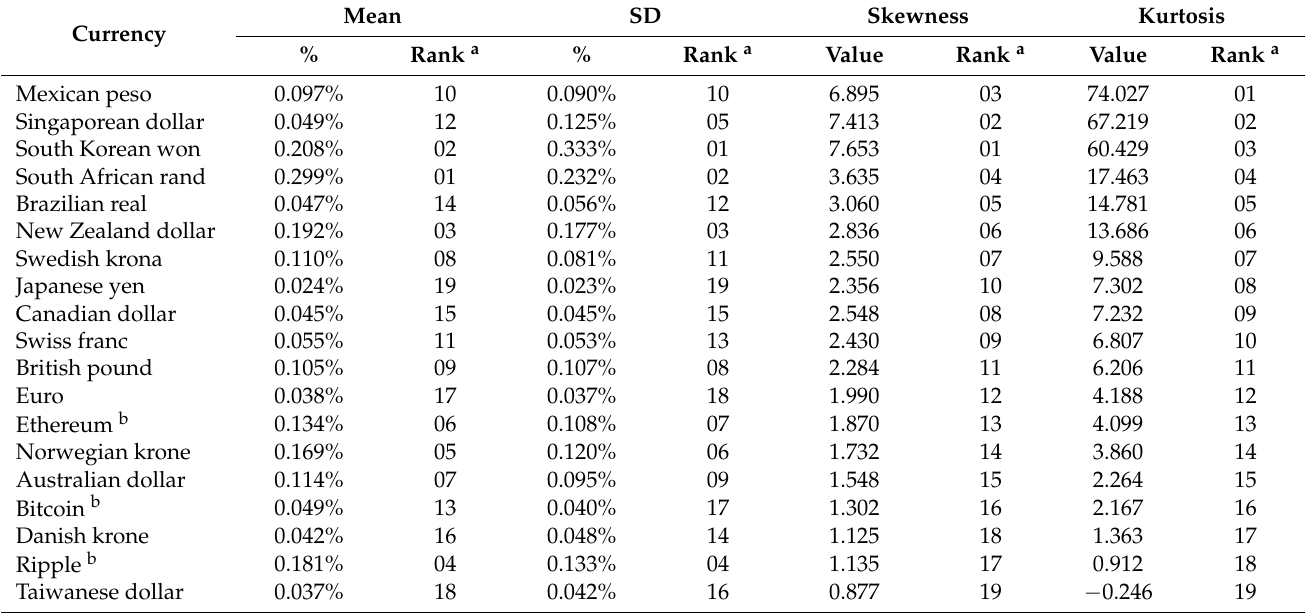
Table 2. Bid-ask spread rate (log-transformation), descriptive